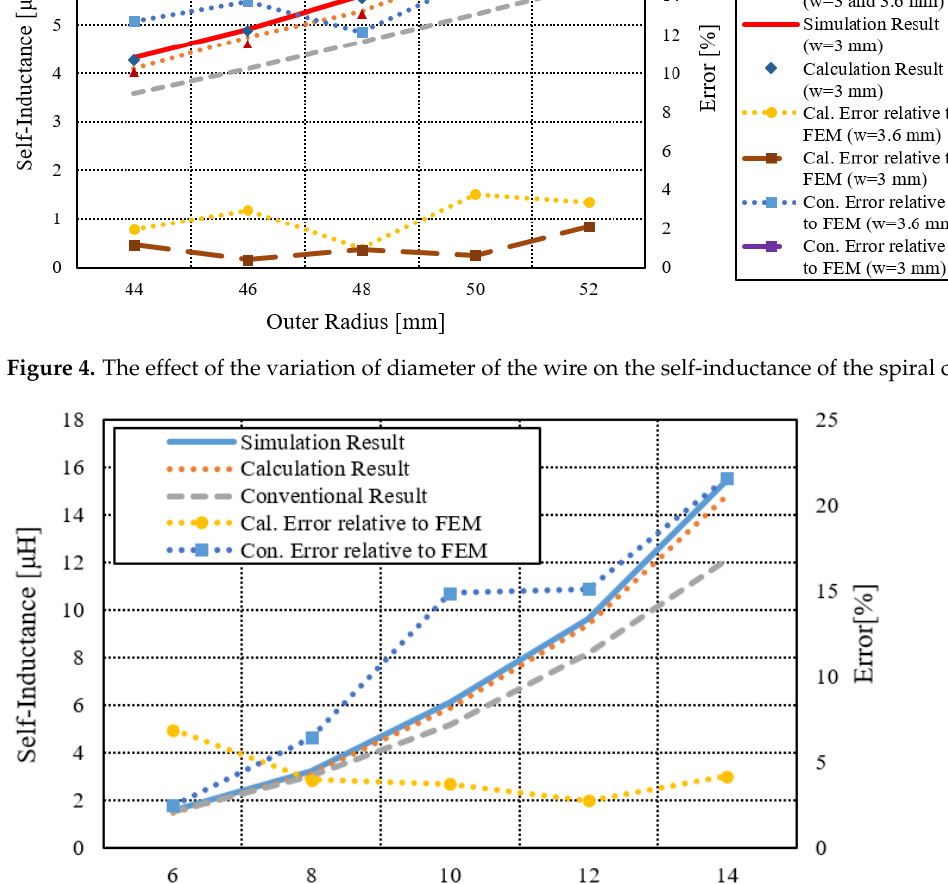
Figure 4. The effect of the variation of diameter of the wire on the self-inductance of the spiral coil.